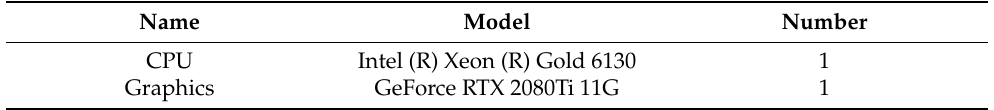
Table 3. Experiment environment configuration.